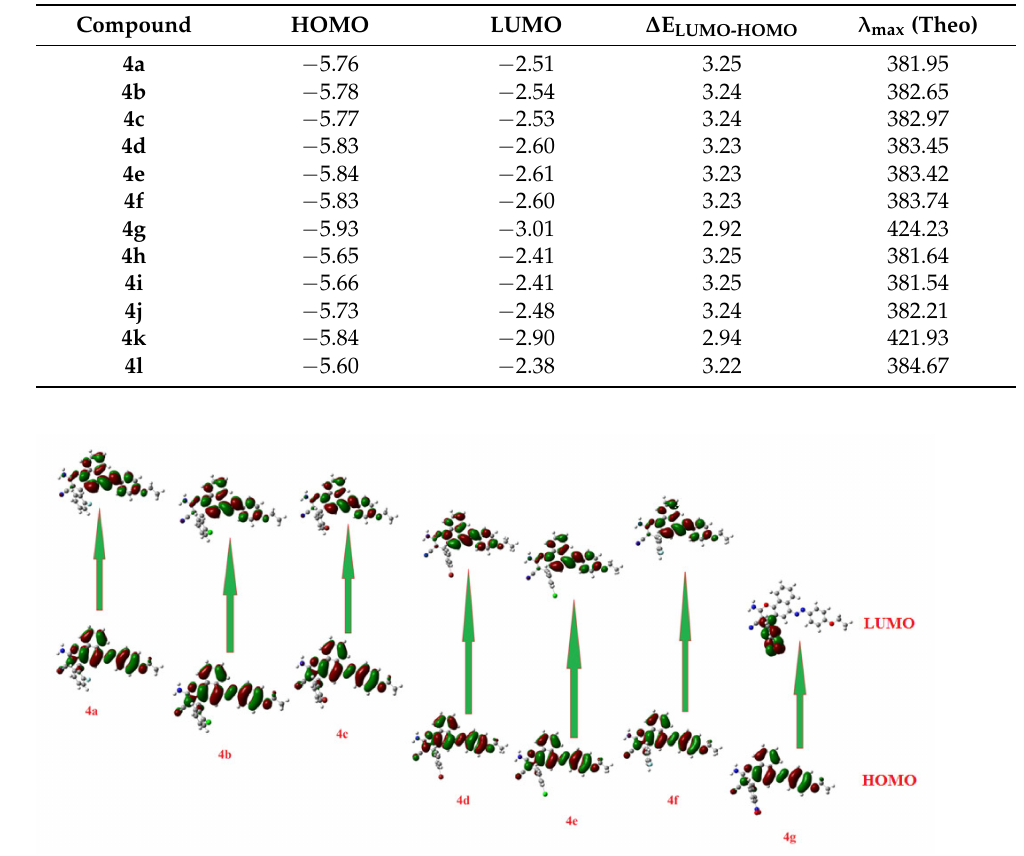
Figure 4. Molecular orbital spatial distribution and localization for the HOMO (highest occupied) and LUMO (lowest unoccupied) of 4a-g .